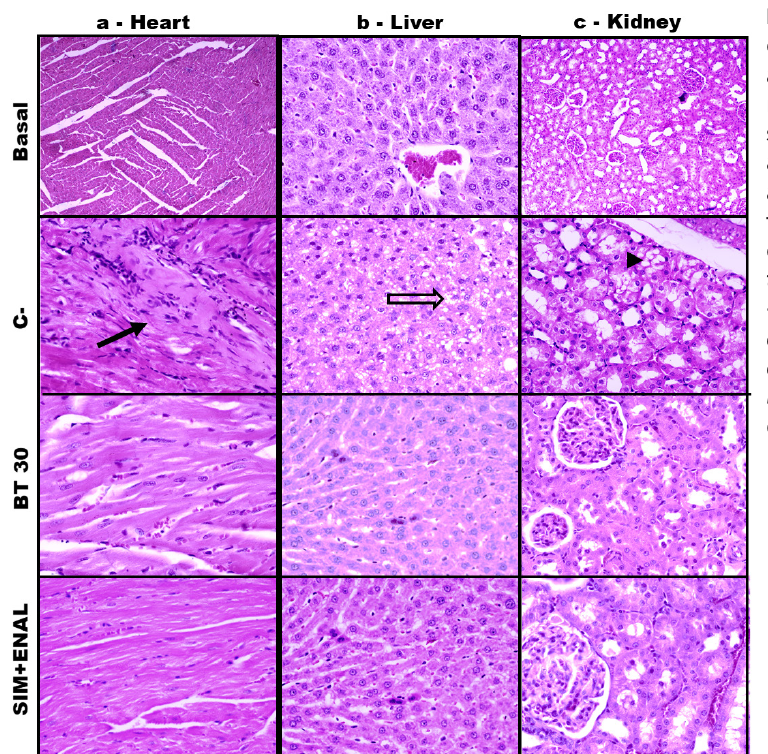
Figure 4. Histopathological evaluation of the heart (a) , liver (b) , and kidneys (c) in normotensive, non-dyslipidemic, and non- smoker Wistar rats (basal group) and hypertensive, dyslipidemic, and smoker Wistar rats that were treated with vehicle (negative control [C–]), 30 mg/kg Baccharis trimera (BT 30), and simvastatin + enalapril (SIM+ENAL). The black arrow indicates fibrosis. The open arrow indicates steatosis. The black arrowhead indicates tubular